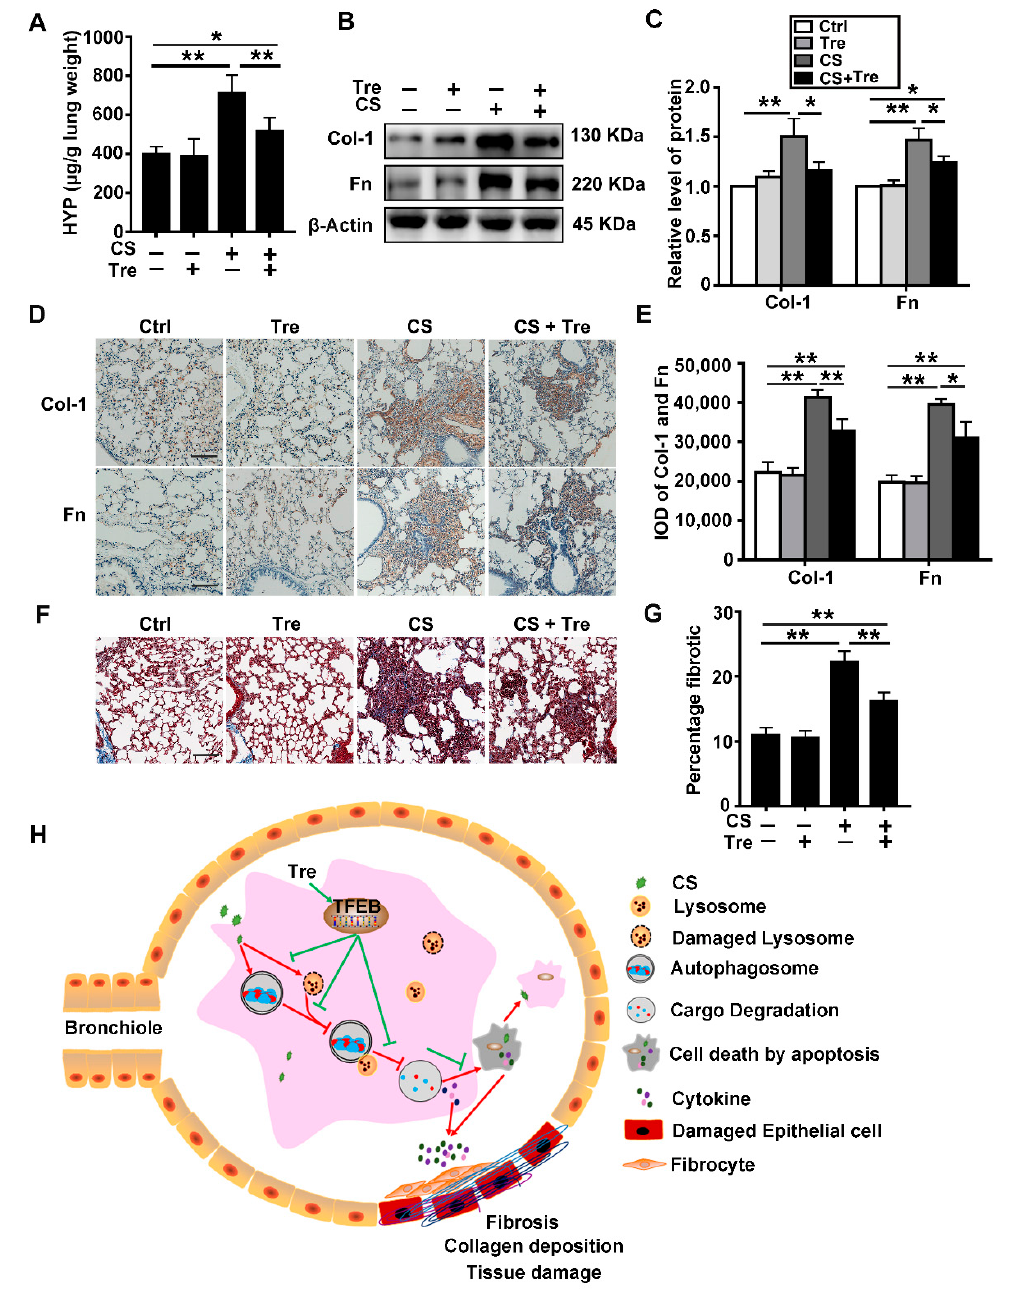
Figure 8. Tre relieves CS-induced pulmonary fibrosis. ( A ) HYP content in lung tissue was measured on day 56 post CS instillation ( n = 5). ( B , C ) Immunoblotting analysis of Col-1 and Fn protein levels in mouse lungs on day 56 post CS treatment ( n = 5 to 6). ( D , E ) Immunohistochemical staining and analysis of Col-1 and Fn levels in para ffi n sections of mouse lung on day 56 post CS treatment. ( F ) Masson’s trichrome staining of mouse lungs on day 56 (scale bar = 100 µ m and n = 5). ( G ) Fibrotic score analysis of the lung sections on day 56 post CS instillation. The fibrotic area is presented as a percentage. Data are presented as the mean ± SD. *, p < 0.05 and **, p < 0.01. ( H ) Illustration of the protective e ff ects of Tre on CS-induced lung inflammation and fibrosis through the activation of the TFEB-dependent autophagy-lysosome machinery. CS impairs lysosomal function, inhibits autophagosome-lysosome fusion, and impairs autophagic substrate degradation. Tre induces TFEB nuclear translocation and improves the function of the autophagy-lysosomal system, leading to decreased apoptosis and secretion of inflammatory factors to alleviate CS-induced lung tissue injury and fibrosis.